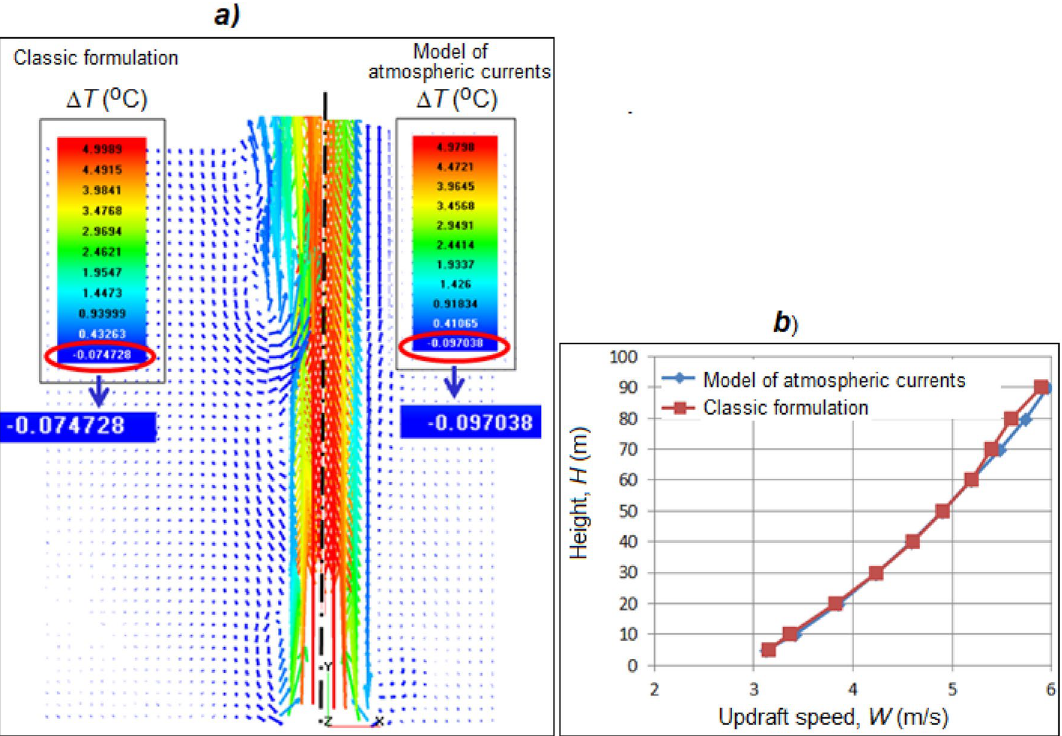
Figure 4. Comparison of the flow patterns in the classical formulation and in the FlowVision atmospheric current model: ( a ) the velocity field with the coloring of the vectors for the temperature rise Δ T (°C); ( b ) dependence of the updraft speed W (m/s) on the